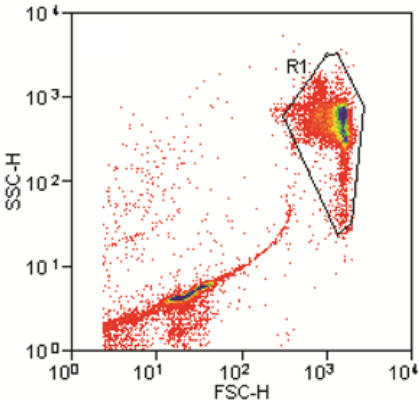
Figure A1. Parallel flow cytometer analysis of a mixture of w/o/w double emulsion droplets, containing 0.025 μ M FITC in PBS, 0.25 μ M FITC in PBS and 2.5 μ M FITC in PBS in the inner aqueous droplets. The FSC vs. SSC log-log dot-plot shows one distinct main population of double emulsion